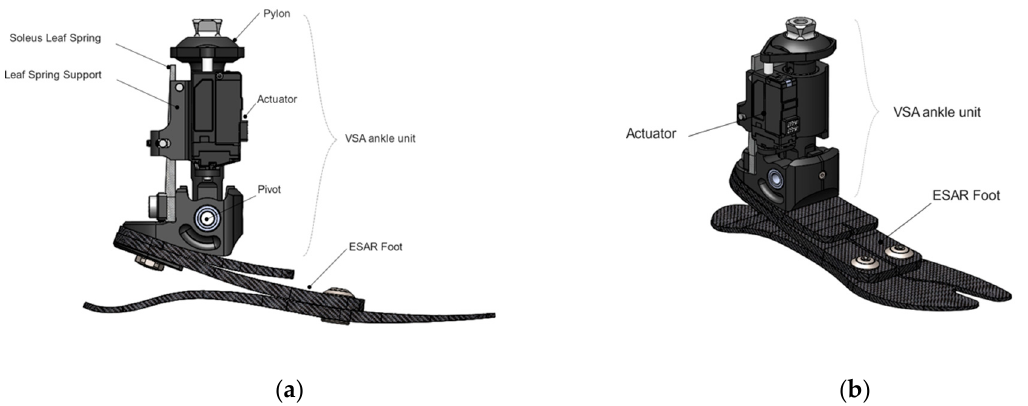
Figure 1. VSA prosthetic foot drawing: ( a ) sagittal view and ( b ) isometric view.